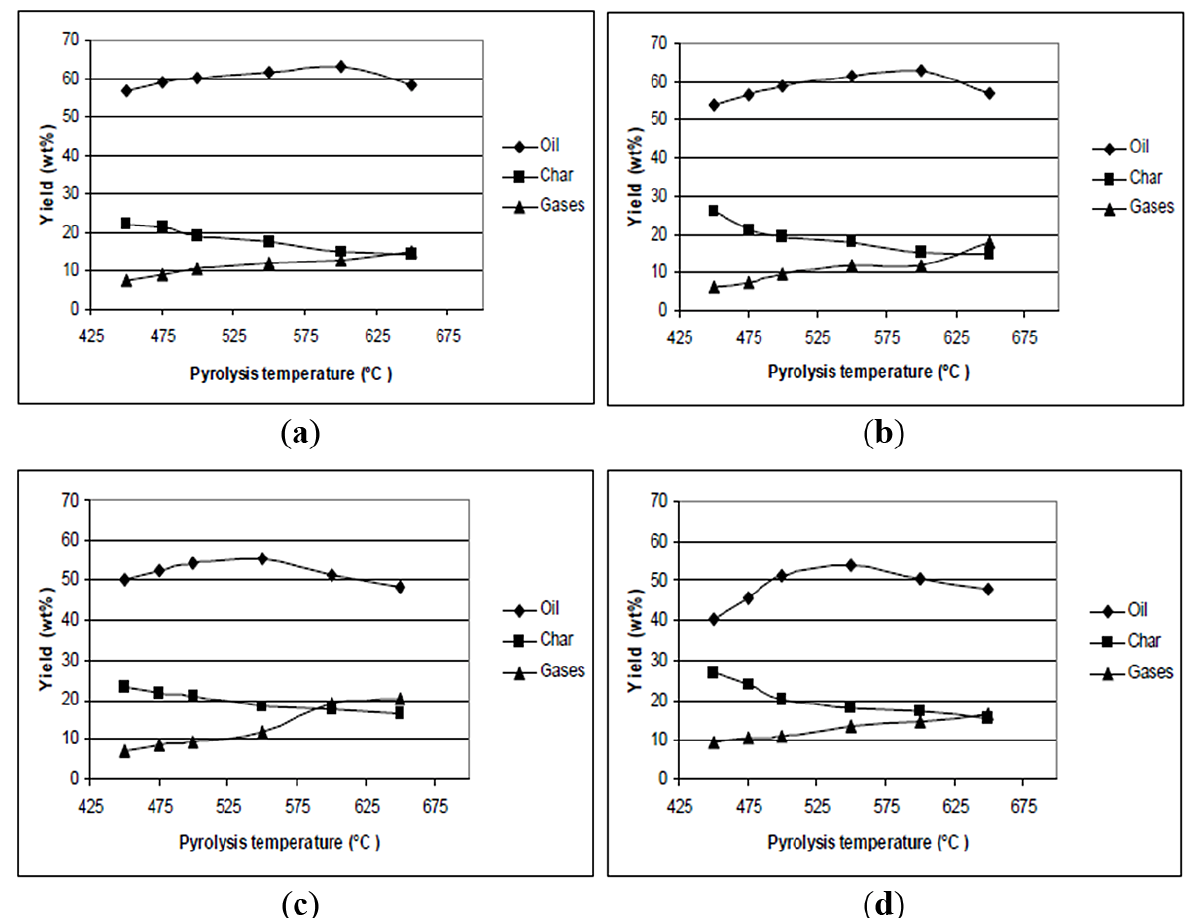
Figure 5. Change in the yield of oil, char and gases versus the pyrolysis temperature of wood at drying parameters of: ( a ) 200 °C, 45 min; ( b ) 200 °C, 90 min; ( c ) 240 °C, 45 min; ( d ) 240 °C, 90 min [100].